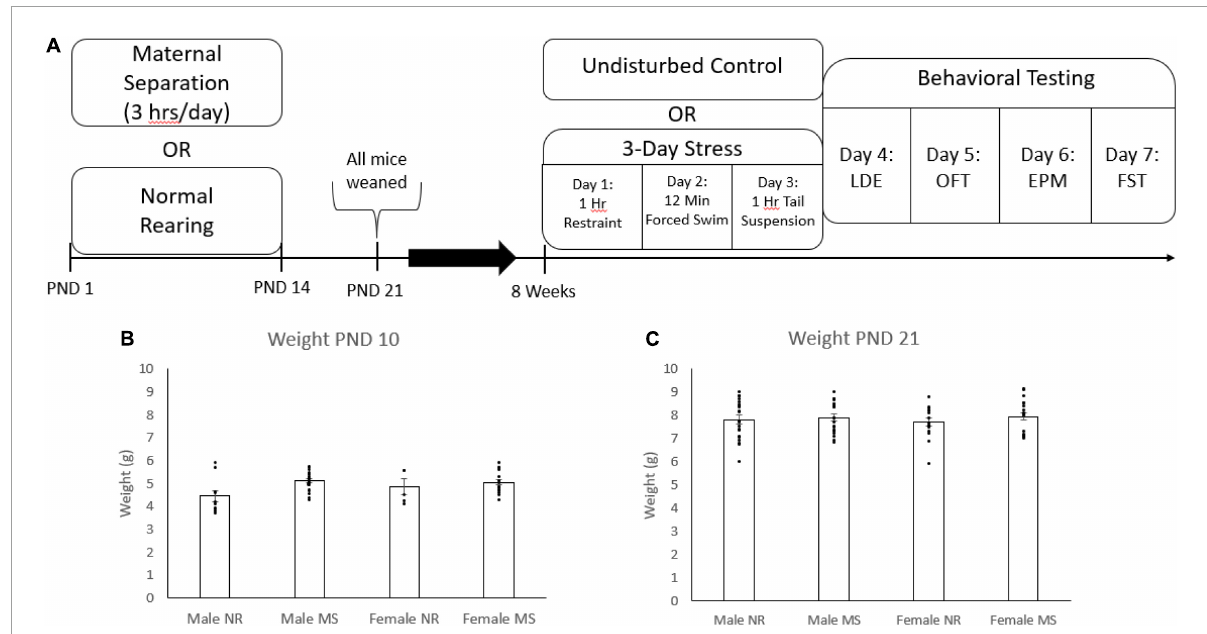
FIGURE1 The timeline of stressors and behavioral tests throughout the study (A) . Mice were weighed at PND 10 (B) and PND 21 (C) . Error bars represent the standard error from the mean, and individual data points are included. For PND 10, N = 10 for male NR, 21 for male MS, 7 for female NR, and 20 for female MS. At PND 21 N = 21 for male NR, 21 for male MS, 15 for female NR, and 20 for female